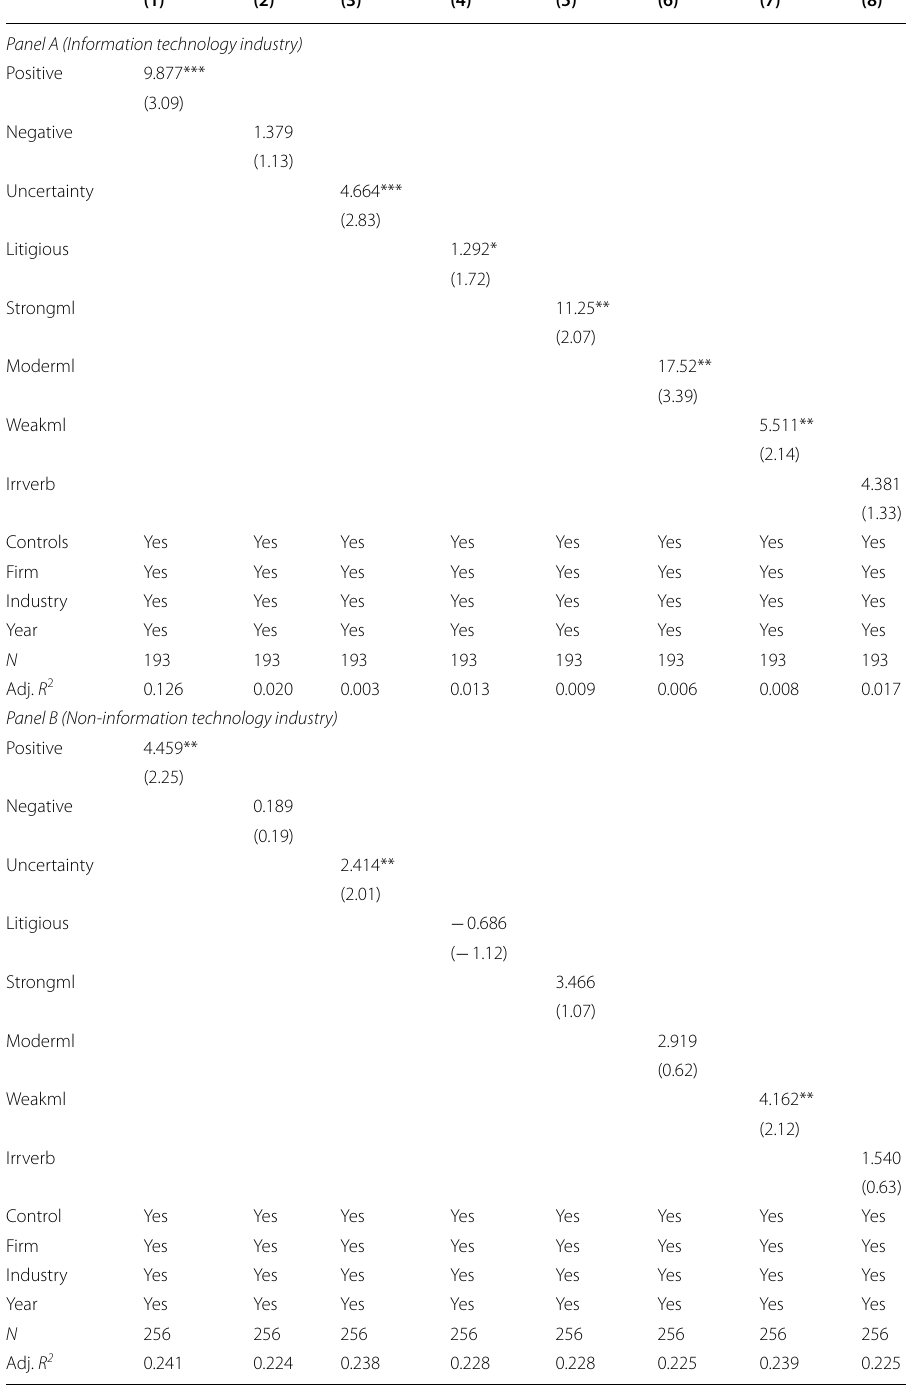
Table 8 Information technology industry versus non-information technology